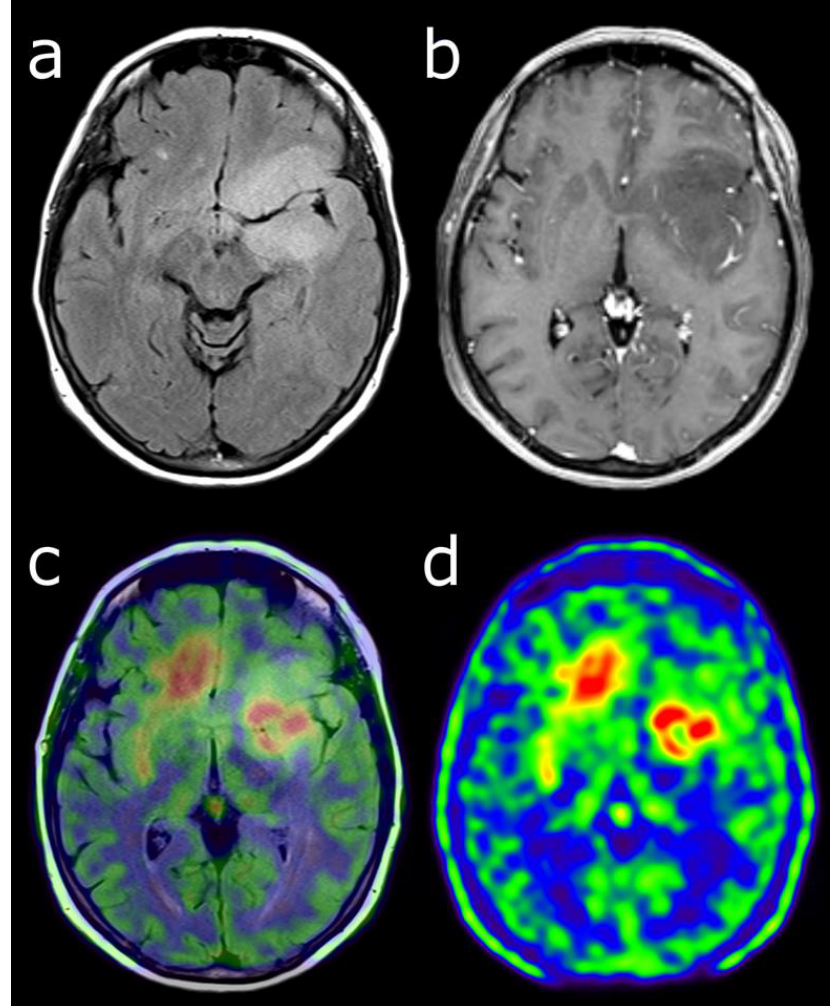
Figure 1. Characterization of a left temporo-fronto-insular brain lesion in a 60-year-old woman. This lesion was considered suggestive of grade II or III glioma according T2-FLAIR ( a ) and post-enhancement T1-weighted MRI ( b ). [18F]FDOPA PET images (fused with T2-FLAIR MRI ( c ) and PET only ( d )) showed an uptake more intense than twice the normal cortex, predictive of high-grade tumor. Moreover, the lesion visualized with PET was much more extended than with MRI, particularly in the contralateral frontal lobe. Pathological analysis of biopsy samples revealed a WHO grade